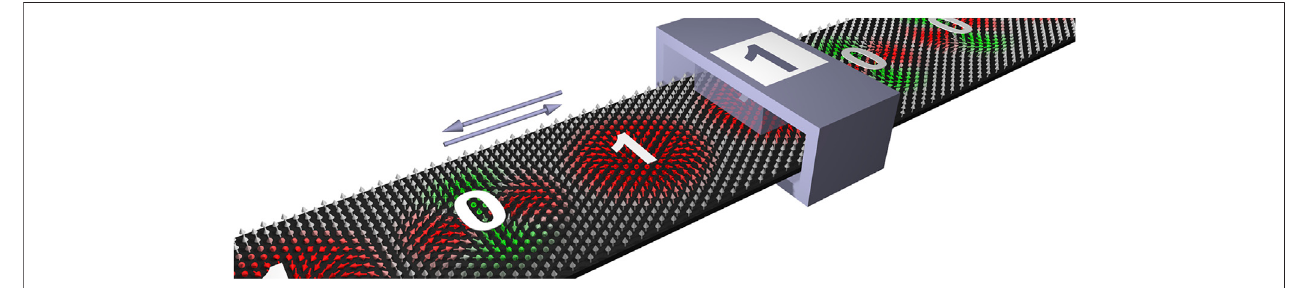
FIGURE 1 | Schematic picture of a skyrmion-antiskyrmion racetrack. Information isencoded in the type of the magnetic particle, i.e., askyrmion represents the bit “ 1 ” and an antiskyrmion represents the bit “ 0 ” . By applying a current, the magnetic particles can be moved towards a read/write head.